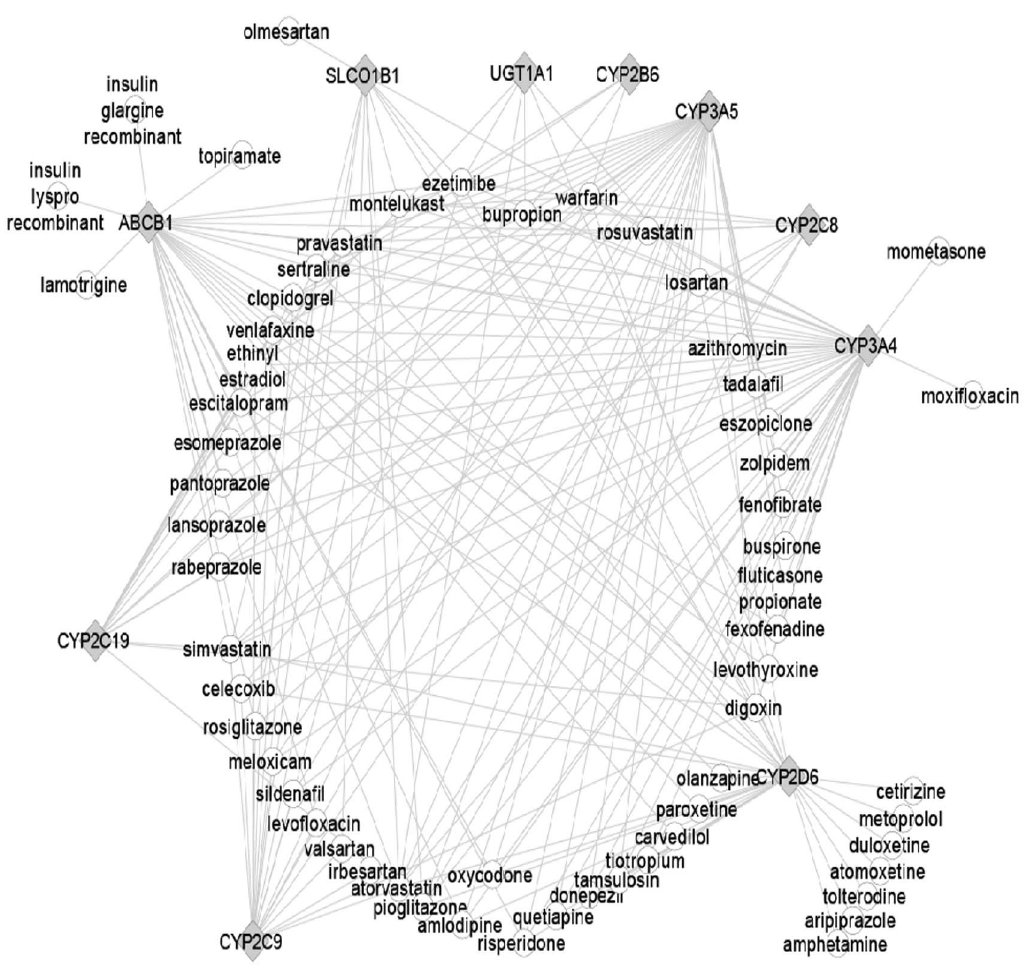
Figure 5. Drug-gene interaction network. The figure indicates the relationship among the ten most influential DMETs and the top 100 prescribed medications. A line between a gene and a drug suggest that the DMET is involved in the metabolism or transporting of the drug. A drug is labeled as a circle and a gene is labeled.